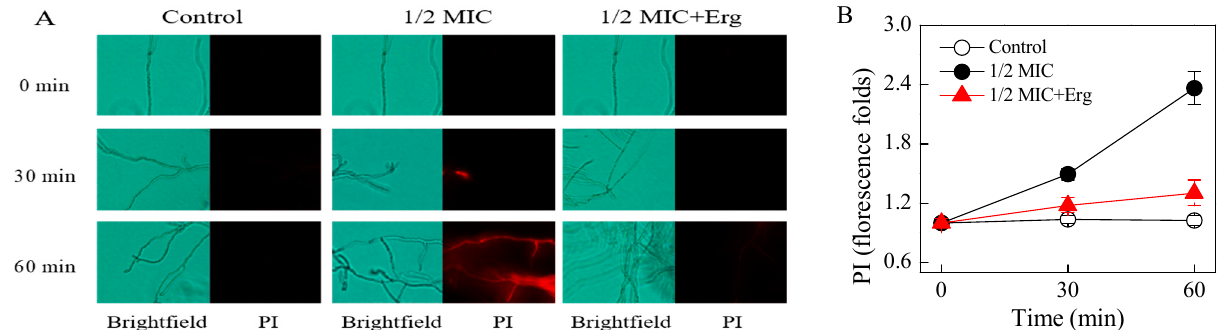
Figure 2. Effects of citronellal on the plasma membrane integrity of P. digitatum ( A ) PI staining images of P. digitatum mycelia treated with citronellal for 0, 30, and 60min; ( B ) the fluorescence fold changes of the PI staining). The data presented are the means of pooled data. Error bars indicate the SDs of the means ( n =